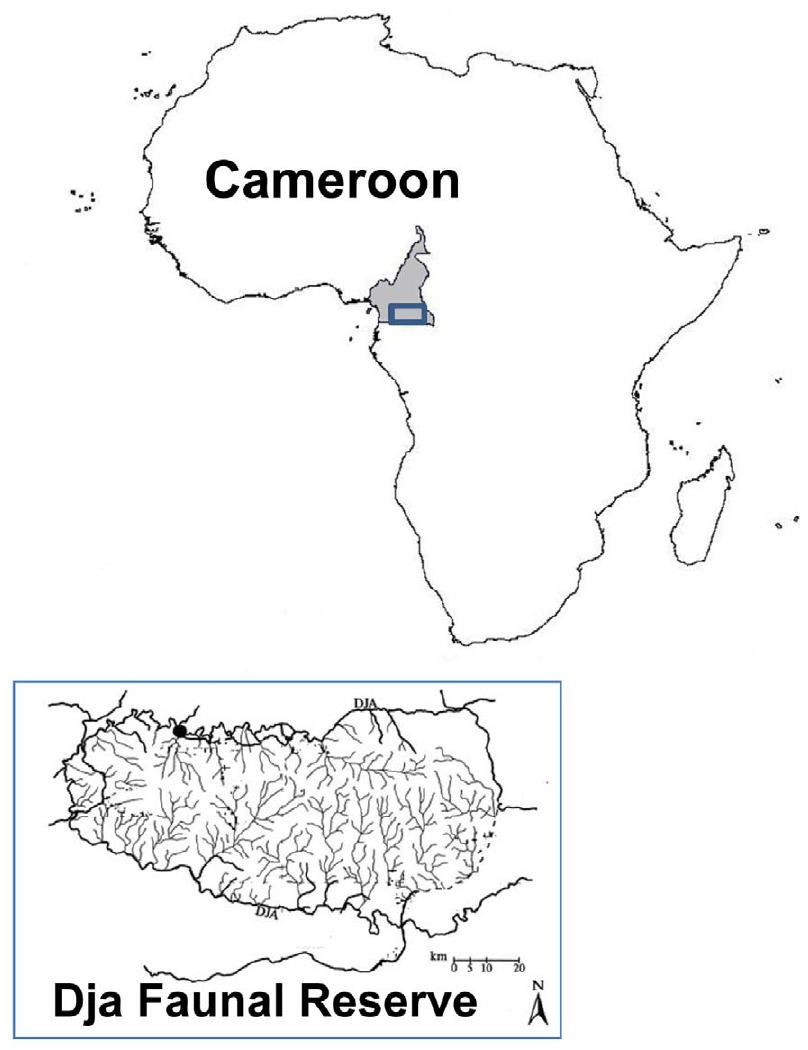
Figure 1. Map of study location at Dja Faunal Reserve in Cameroon.